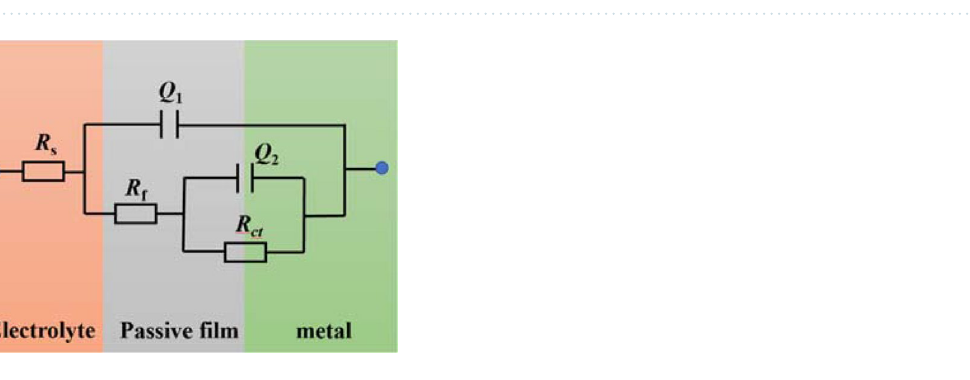
Figure 3. Equivalent circuit diagram of EIS curve fitting.